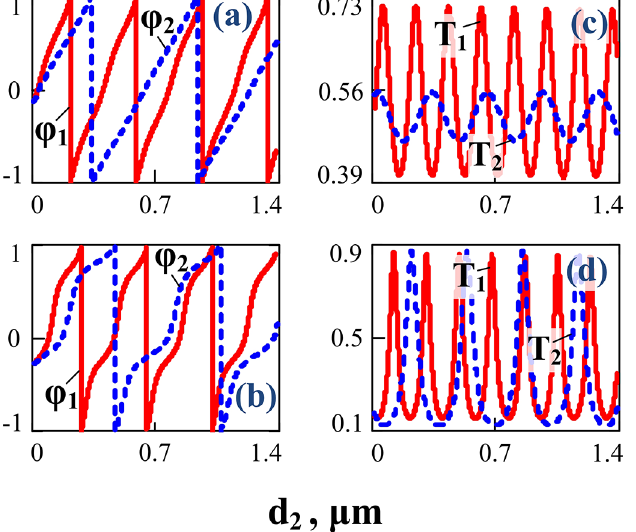
Fig. 6. Dependences of phase differences ’ 1,2 (a, b) and energy transmission coef fi cients T 1,2 (c, d) of waves 1, 2 on the main layer thickness d 2 for various materials of layers 1, 3. The values of parameters are: e 1 =2 +10 (cid:1) 3 i , e 3 = (cid:1) 13 +0.5 i (a, c); e 1 = e 3 = (cid:1) 13+ 0.5 i (b, d). The values of parameters for all the graphs are: d 1,3 =13 nm, l =0.6 m m. Parameter d 2 is used as the abscissa axis for all the graphs.